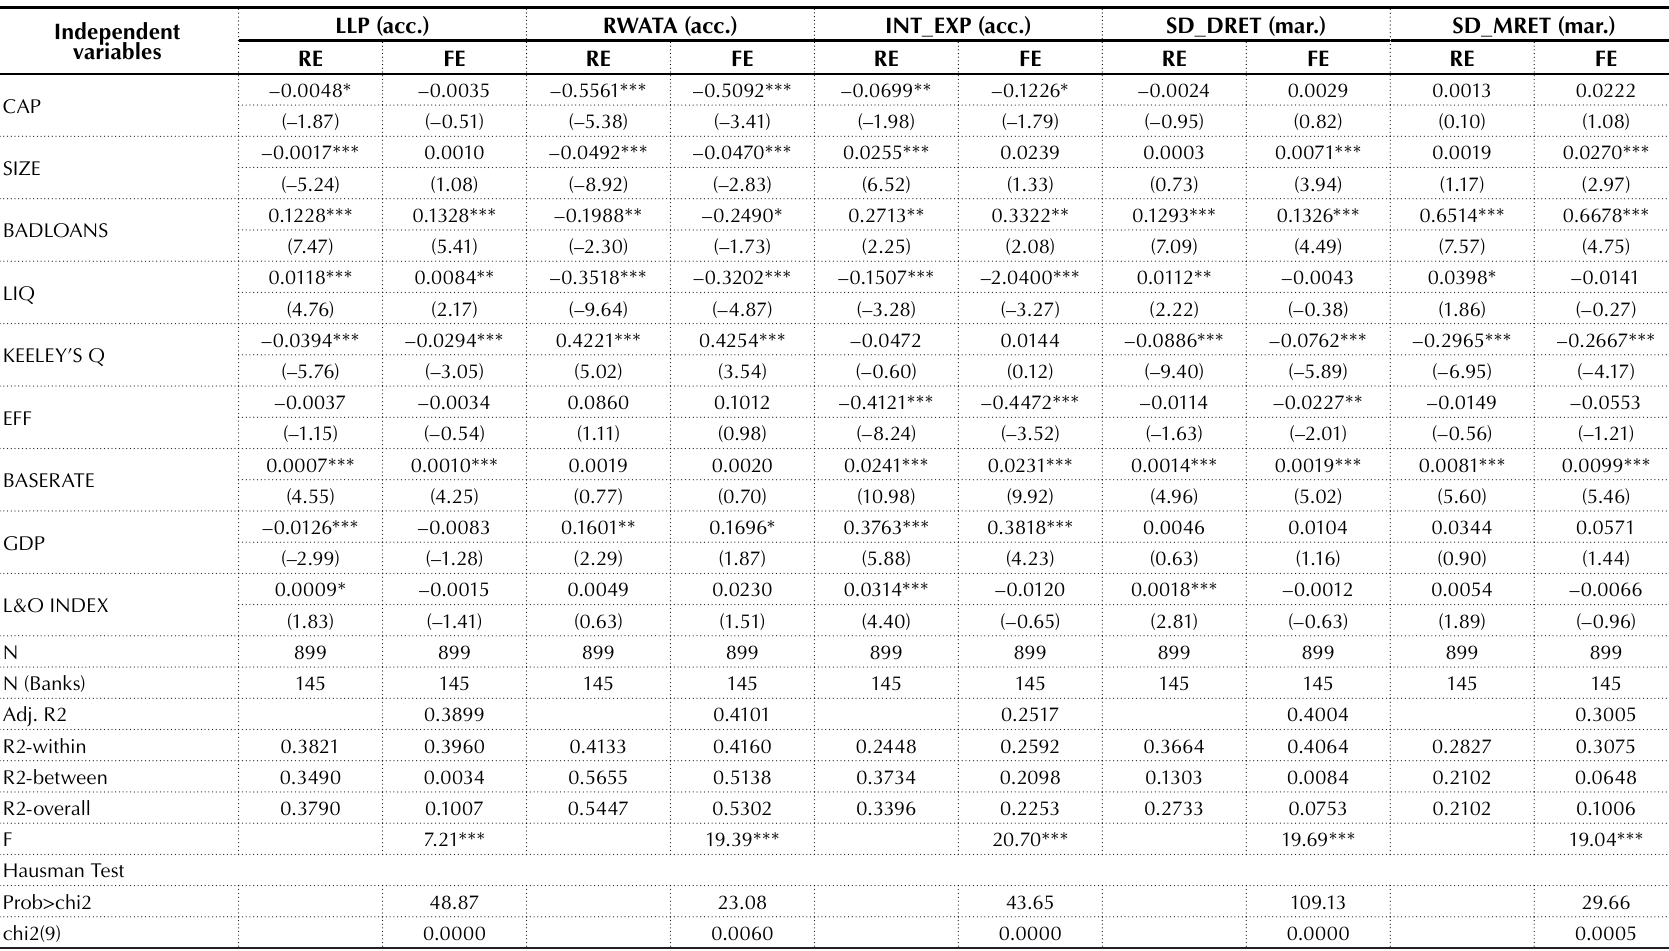
Table 6a. Regression results for accounting and market-based risk measures for the European bank market from 1992 to 2012 Independent